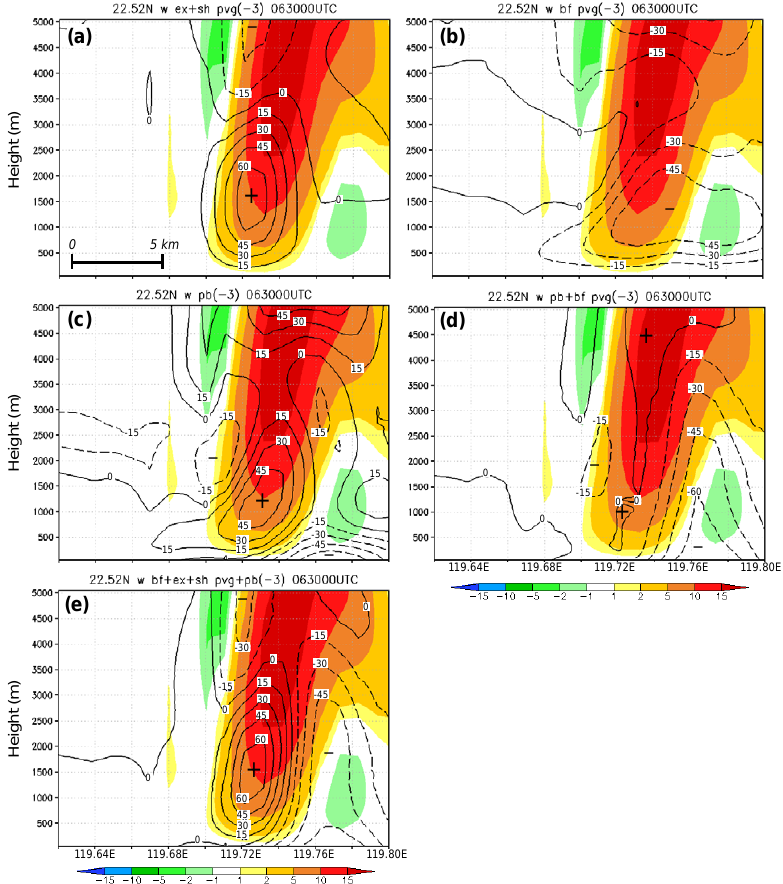
Figure 16. As in Fig. 14, except for w (ms − 1 , color, scale at bottom) and the vertical ( z) component of perturbation pressure gradient force (10 − 3 ms − 2 , contours, every 15 × 10 − 3 ms − 2 , dashed for negative values) from (a) p (cid:48)